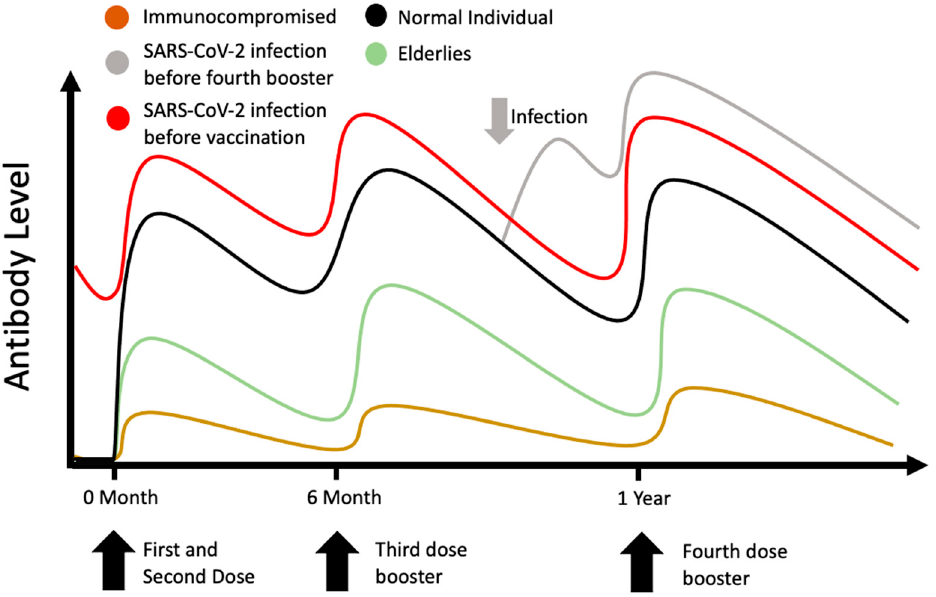
Figure 2. Changes in serum antibodies after vaccination or infection in different patient groups. Elderly patients may have a poorer response to vaccination and lower titre of serum-neutralizing antibodies after vaccination [33,37,38]. Immunocompromised patients, especially patients with solid organ transplants, may have suboptimal response to vaccination with a low level of neutralizing antibodies or being seronegative after the third and fourth booster doses [40,41,51–53]. Individuals who were infected before vaccination or have breakthrough infection after vaccination were demonstrated to have a higher level of neutralizing antibodies